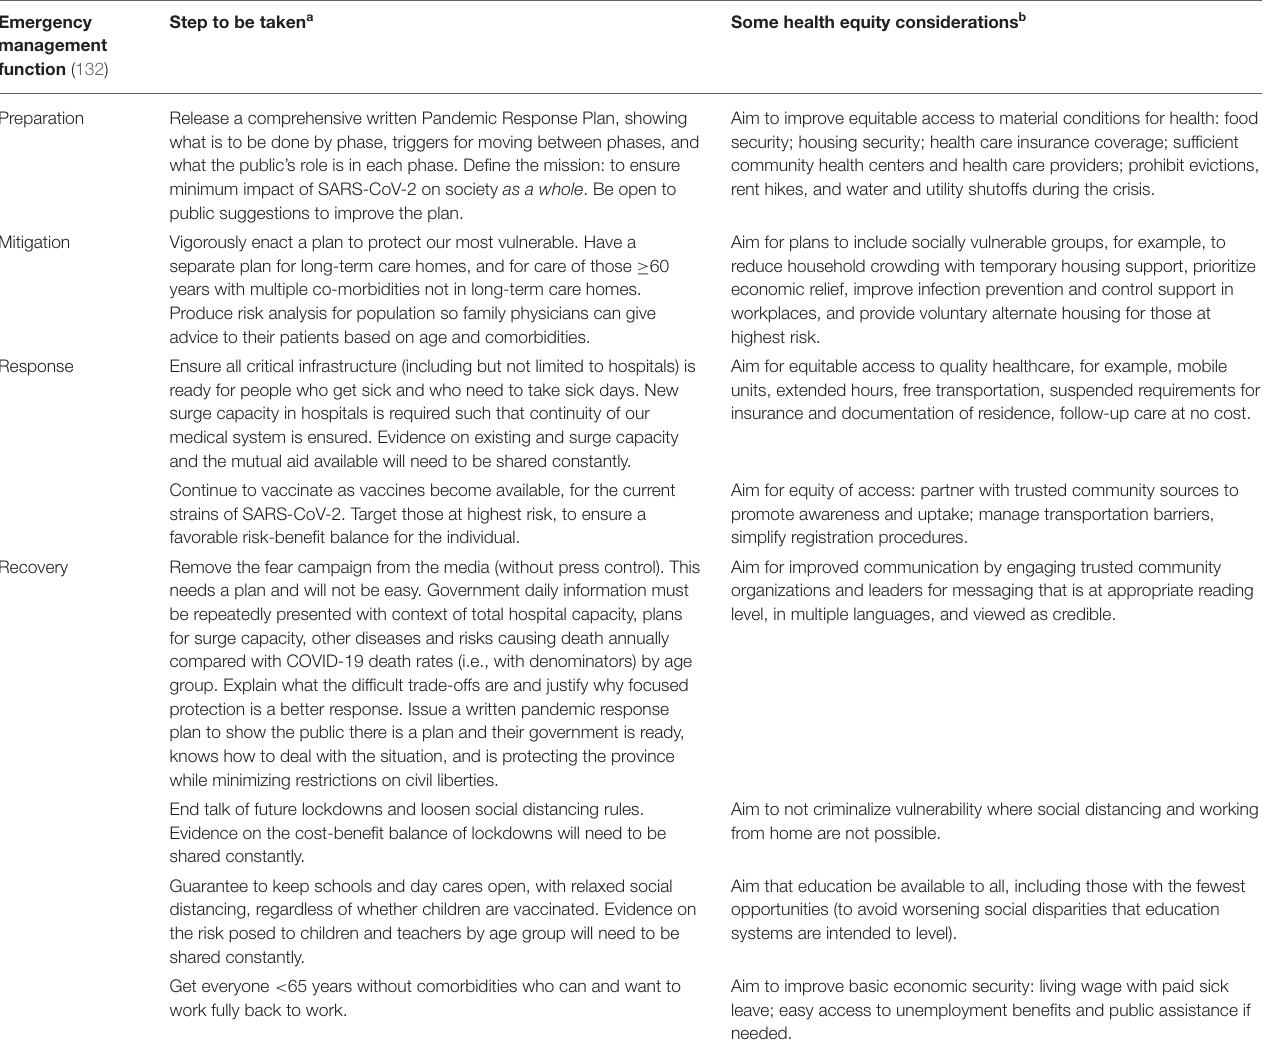
TABLE 8 | Next steps for a better way forward focusing on the concurrent emergency management